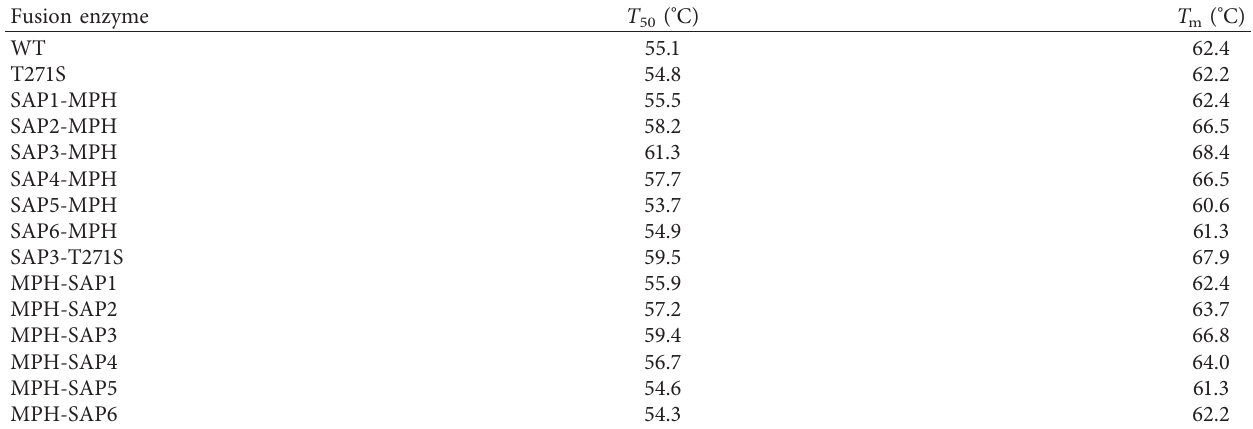
Figure 4: Expression cassettes of MPH fused with SAP. (a) SAP fused at the N-terminus of MPH via a PT-linker (PTPPTTPTPPTTPTPTP). (b) SAP fused at the C-terminus of MPH via a PT-linker. All the expression cassettes were fused with a tag composed of ten histidine residues. Six SAPs were totally used in the constructs (Table S2). Table 2: Thermal stability parameters of MPH fused with